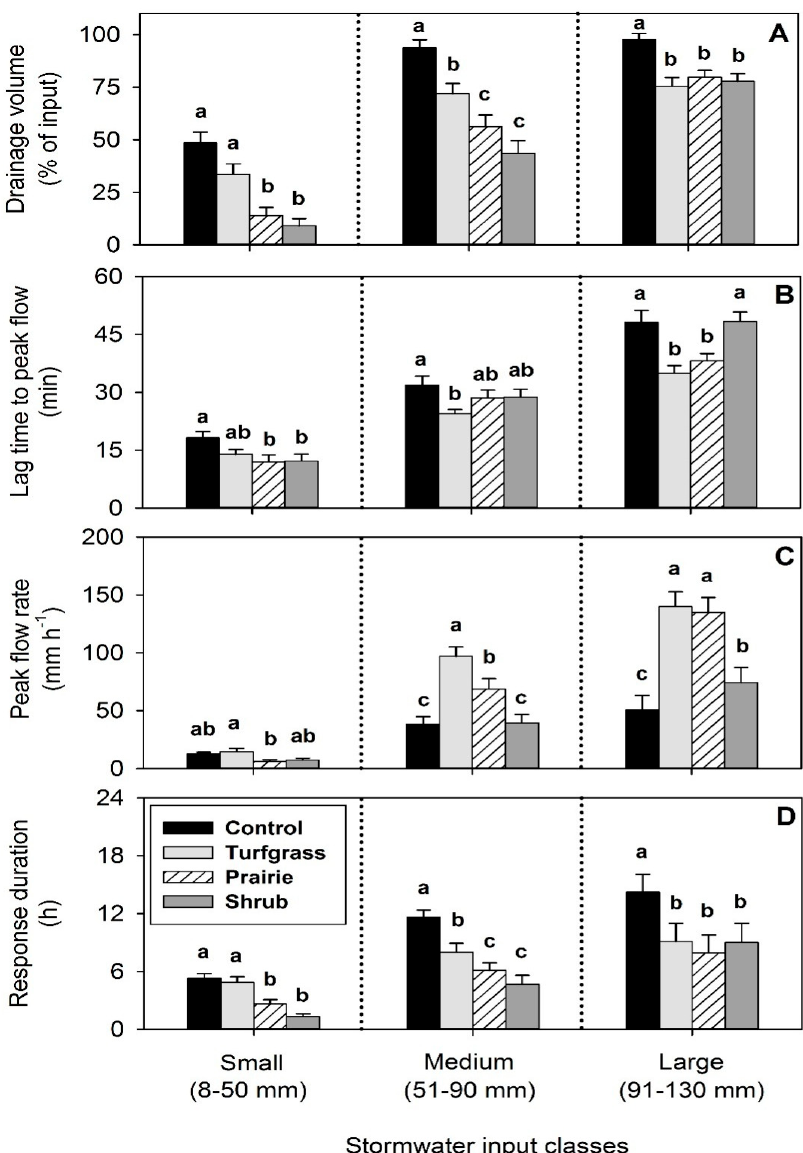
Figure 6. Effect of vegetative treatment on four drainage metrics: ( A ) drainage volume (% of input), ( B ) lag time to peak flow (min), ( C ) peak flow rate (mm h − 1 ), and ( D ) duration of response (h). Input data were separated into three classes by size: small inputs (8–50 mm, 18 events), medium inputs (51–90 mm, 10 events), and large inputs (91–130 mm, 13 events). Different lowercase letters indicate significant differences among treatment means ( n = 3 per treatment) within each respective input size class ( p < 0.05). Plotted values are means ± SEM.